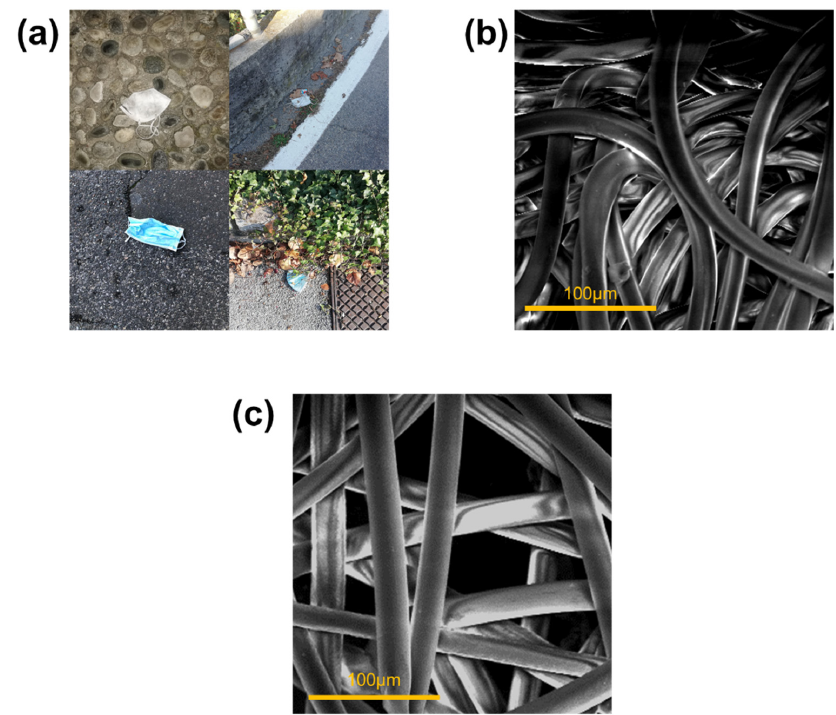
Figure 7. Photos of dispersed masks in Lombardy ( a ). Scanning Electron Microscope (SEM) micro- graphs of the elastic ( b ) and outer surface ( c ) of a surgical mask, showing the fibrous material as a possible source of microplastics.